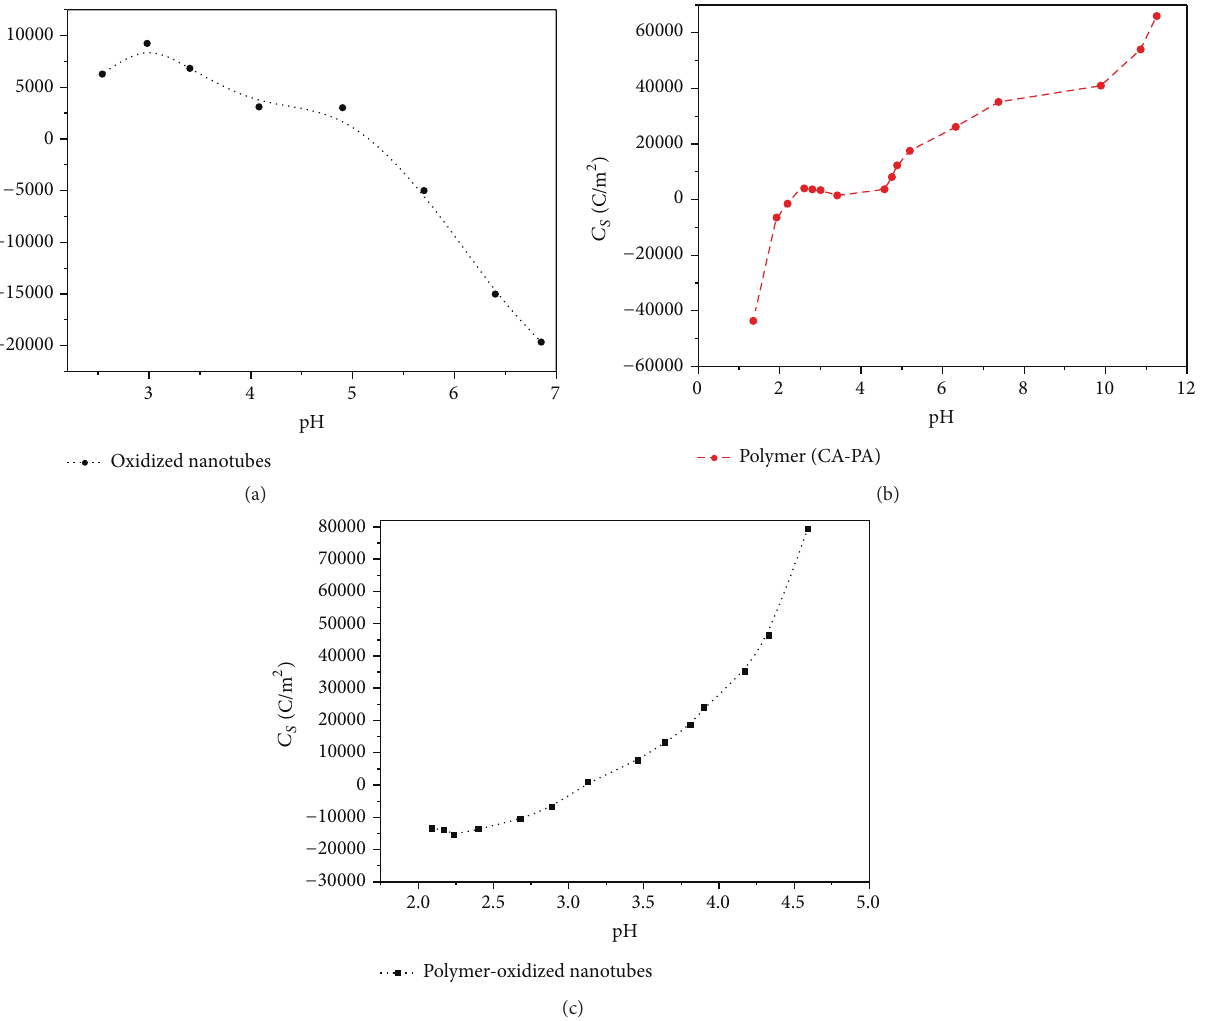
Figure 15: Distribution of the surface charge in the different materials: (a) oxidized carbon nanotubes, (b) polymer (CA-PA), and (c) polymer (CA-PA) with carbon nanotubes.